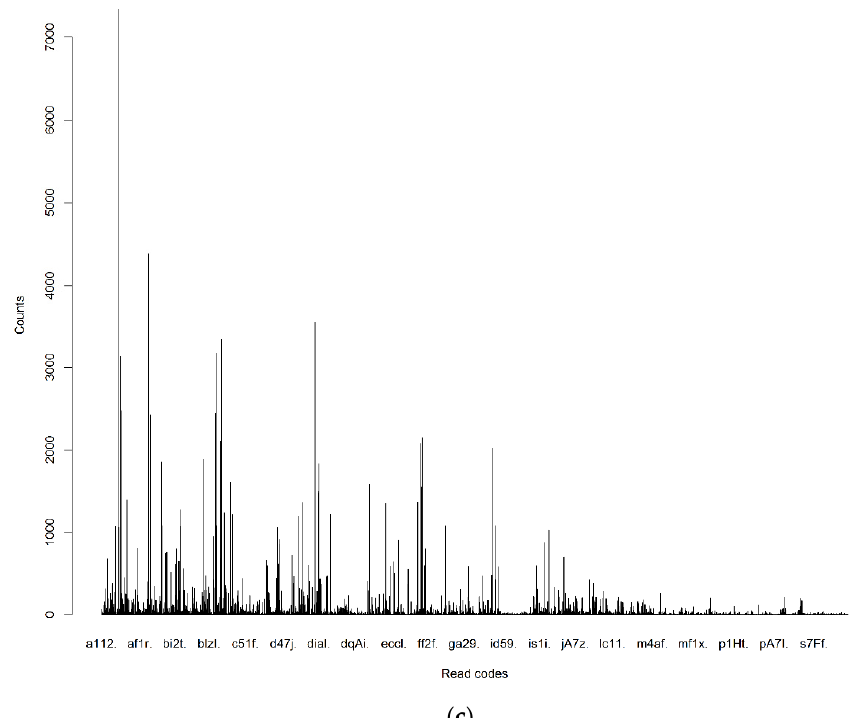
Figure 2. Frequencies of read codes in different categories. ( a ) Frequencies of read codes in PoM; ( b ) frequencies of read codes in DoC; and ( c ) frequencies of read codes in MaA.